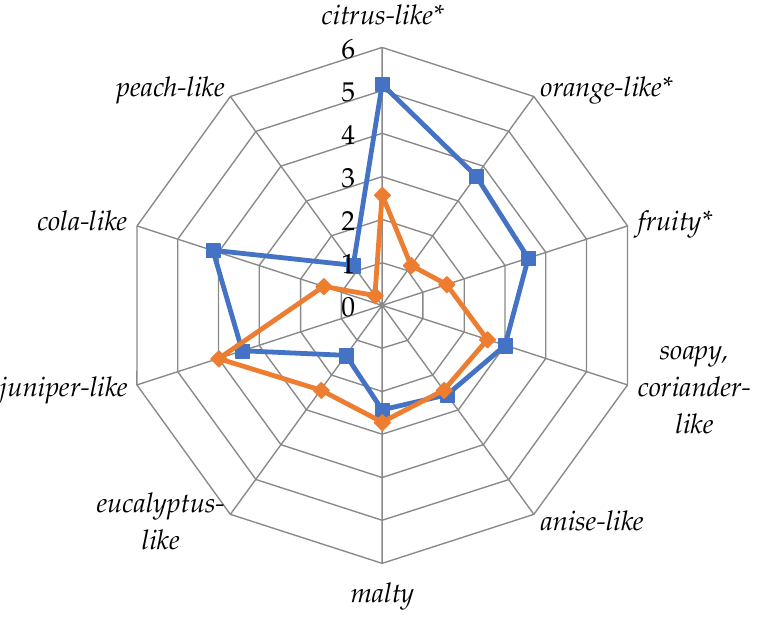
Figure 1. Comparative aroma profiles of the two gins, The King Gin Kini and Gspusi, perceived via orthonasal evaluation. Kini was produced with 50 botanicals, while Gspusi contained 15. Attributes marked with asterisks correspond to significant differences between the gins (p < 0.05), as determined by analysis of variance (ANOVA). Note that the intensity scale has been adjusted to cover the range of rated intensities (maximum rated intensity of 5.1), rather than the full range available (10). The ethanolic odor impression (5.3 for Kini, 7.0 for Gspusi) has been omitted from the profile to focus only on the aroma impressions related to the botanicals.